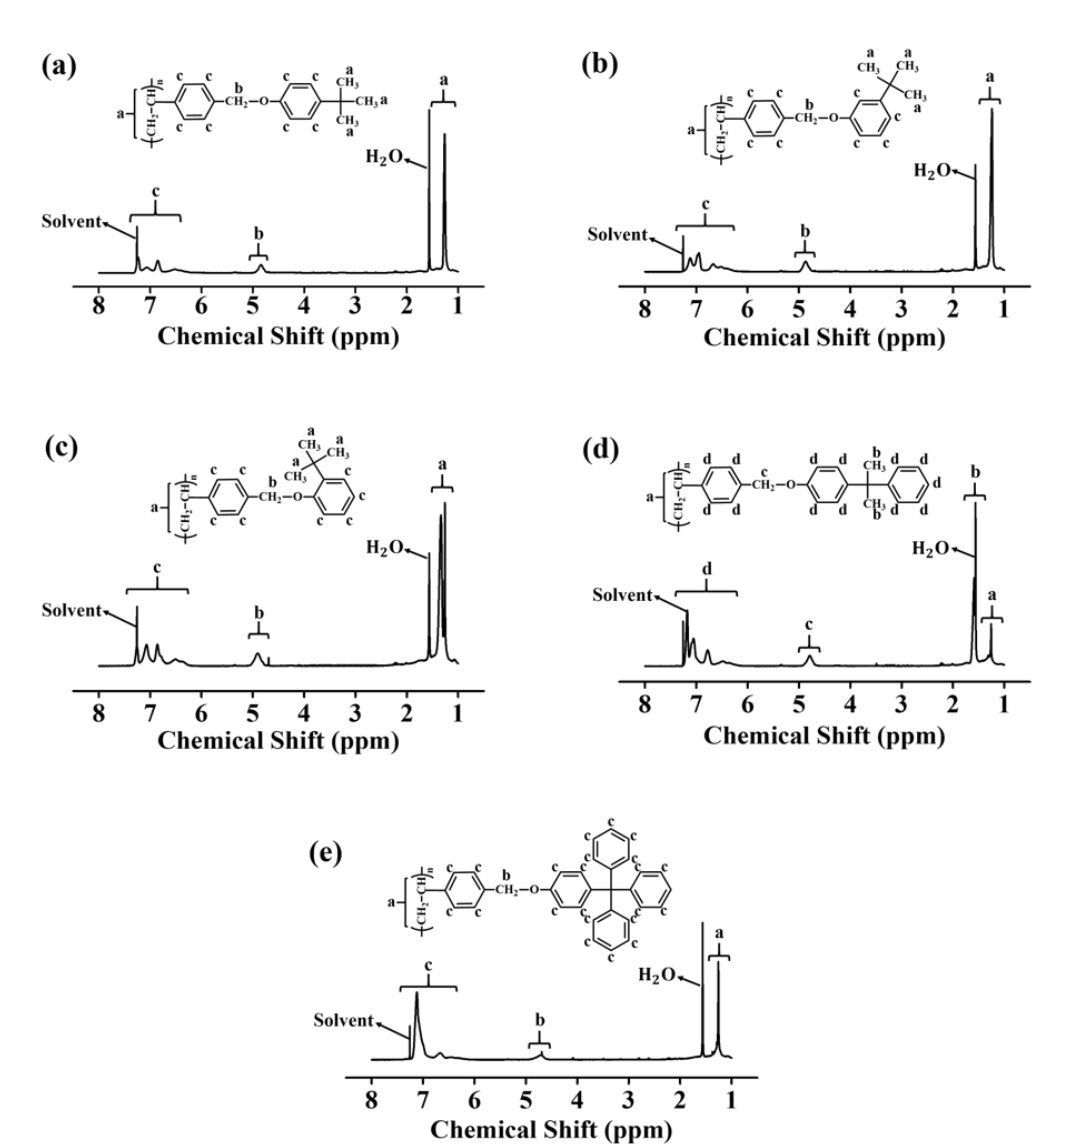
1 H-nuclear magnetic resonance ( 1 H NMR) spectrum of ( a ) P4TB, ( b ) P3TB, ( c ) P2TB, ( d ) PCUM, and ( e ) PTRI.